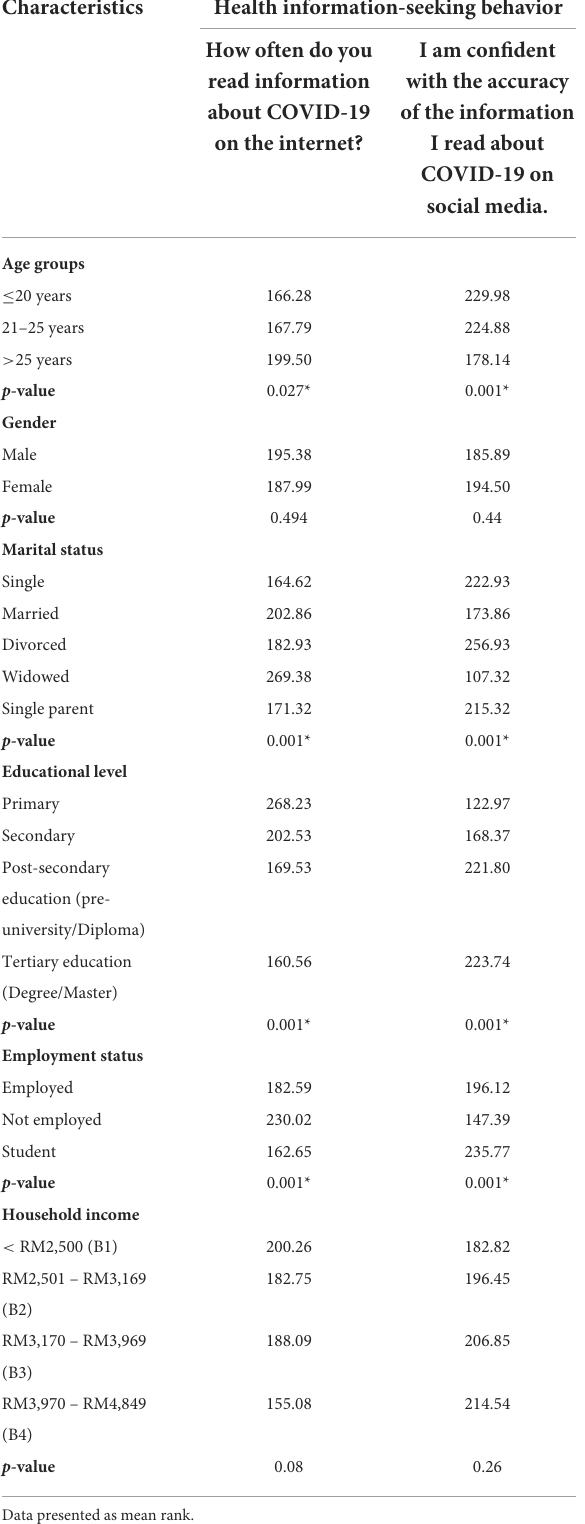
TABLE 4 Comparison of participants’ characteristics and health information-seeking behavior ( n = 301). Characteristics